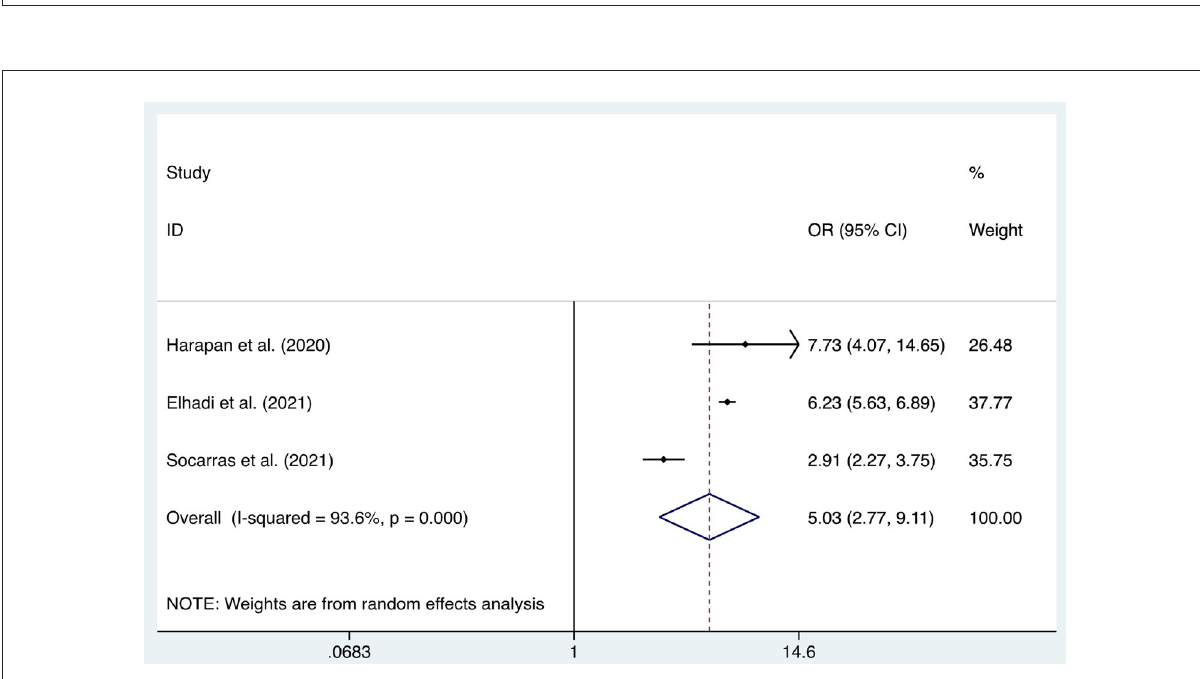
FIGURE6 Forest plot of the acceptance of healthcare workers of coronavirus disease 2019 vaccines with different effectiveness (bounded by 70%).